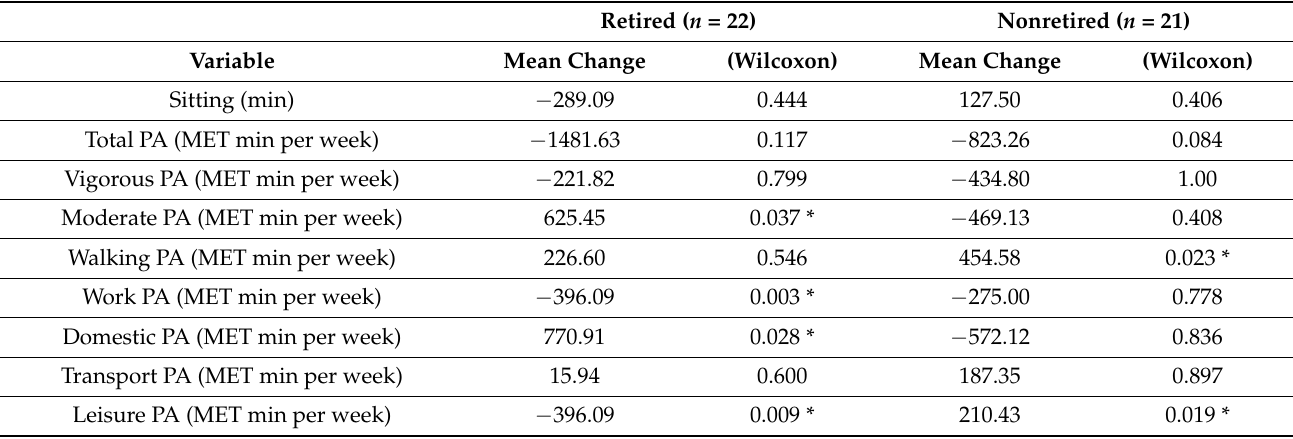
Table 3. Mean change in sitting and PA domains within